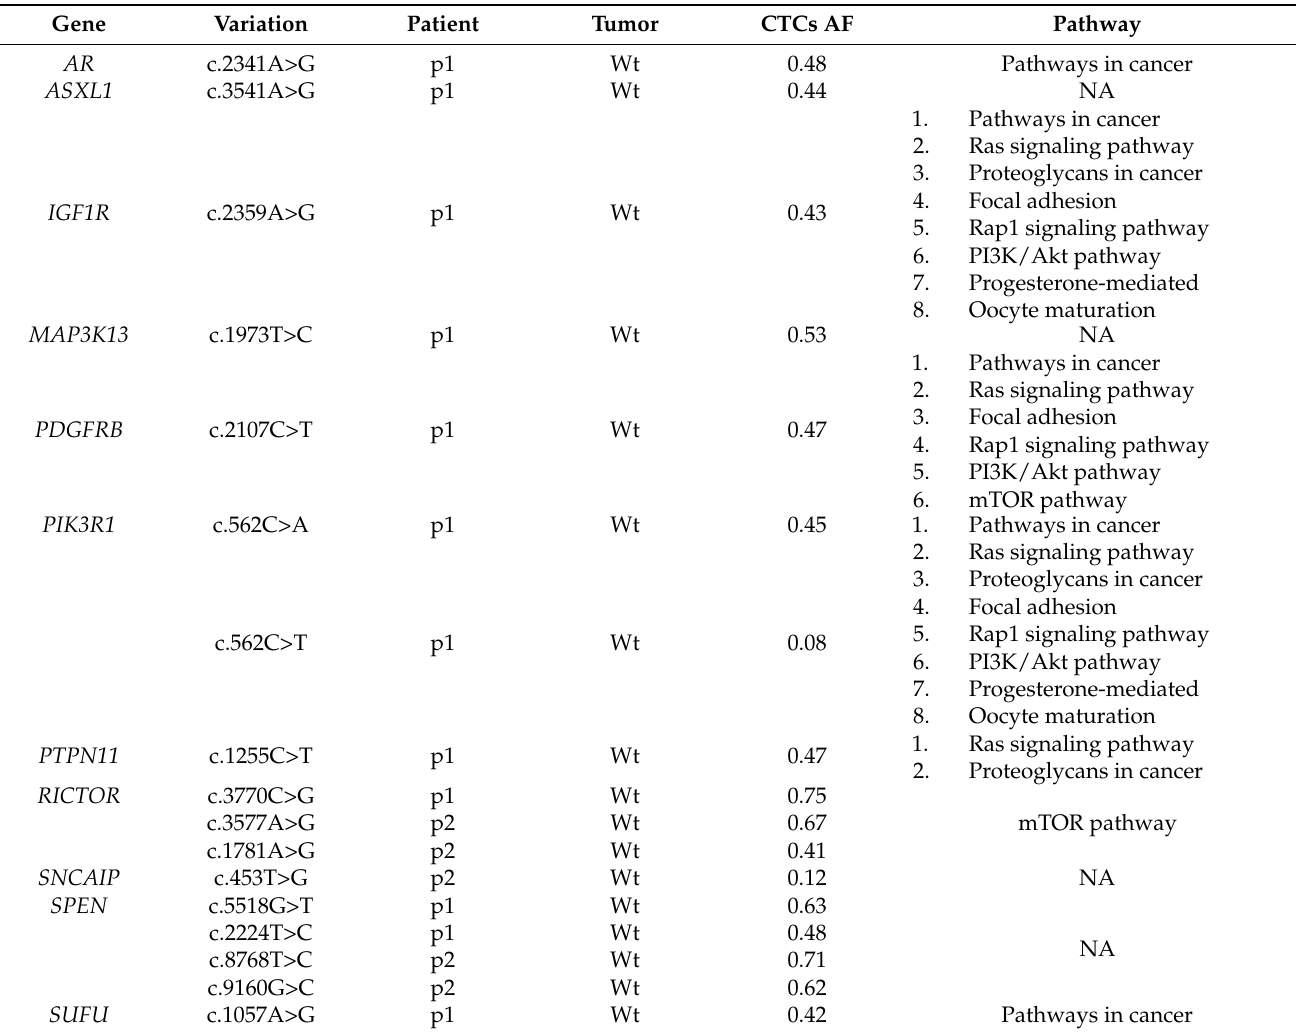
Table 3. Somatic mutations detected in circulating tumor cells (CTCs) of the two EOC patients. Gene Variation Patient Tumor CTCs AF